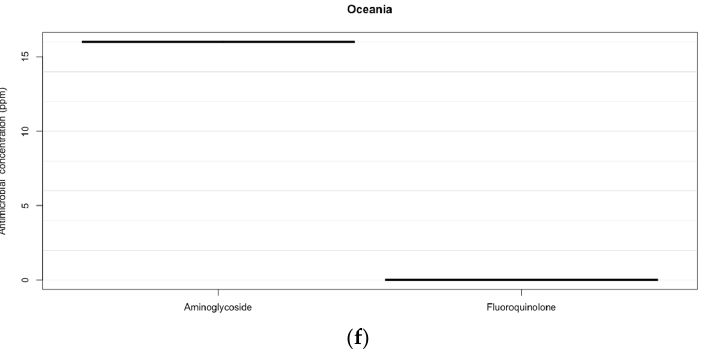
Figure 2. Antibiotics (ppm) used in Asia, Africa, North America, South America, Europe, and Oceania. ( a ) Antibiotics (ppm) used in Asia. Points represent the raw data; bar/line is the descriptive statistic (mean); bean is the smoothed density curve showing the full data distribution; and brackets represent the confidence intervals. ( b ) Antibiotics (ppm) used in Africa. Points represent the raw data; bar/line is the descriptive statistic (mean); bean is the smoothed density curve showing the full data distribution; and brackets represent the confidence intervals. ( c ) Antibiotics (ppm) used in North America. Points represent the raw data; bar/line is the descriptive statistic (mean); bean is the smoothed density curve showing the full data distribution; and brackets represent the confidence intervals. ( d ) Antibiotics (ppm) used in South America. Points represent the raw data; bar/line is the descriptive statistic (mean); bean is the smoothed density curve showing the full data distribution; and brackets represent the confidence intervals. ( e ) Antibiotics (ppm) used in Europe. Points represent the raw data; bar/line is the descriptive statistic (mean); bean is the smoothed density curve showing the full data distribution; and brackets represent the confidence intervals. ( f ) Antibiotics (ppm) used in Oceania. Points represent the raw data; bar/line is the descriptive statistic (mean); bean is the smoothed density curve showing the full data distribution; and brackets represent the confidence intervals.